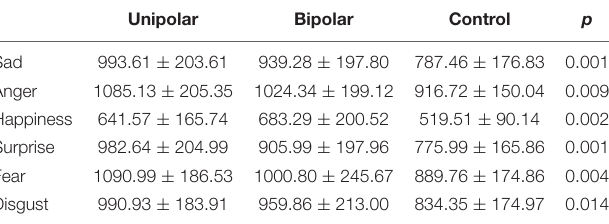
TABLE 3 | Response time among the three groups